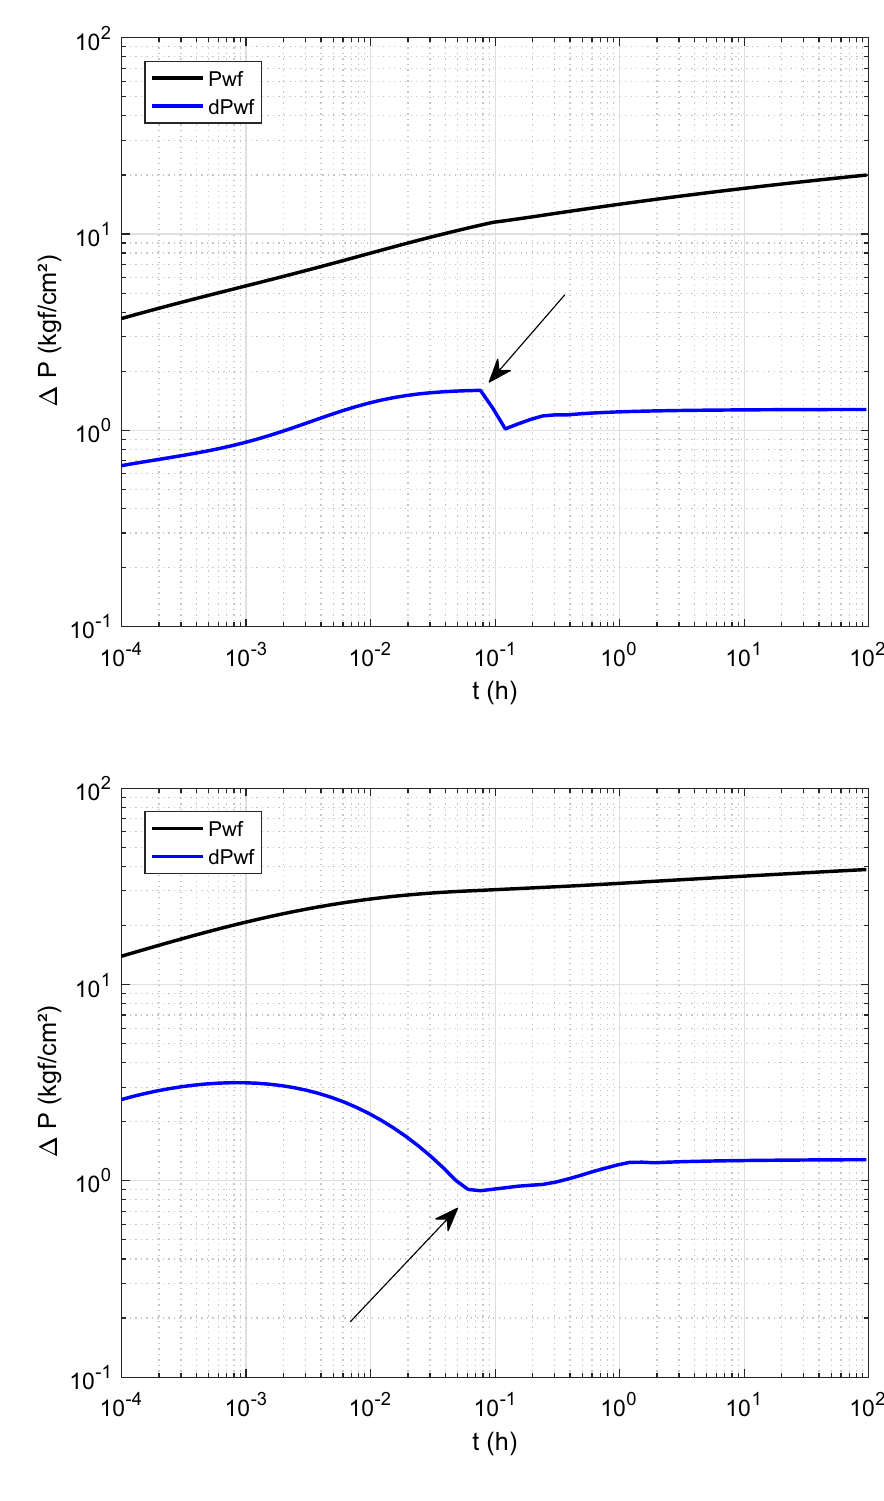
Fig. 1 Pressure and derivative data for case A